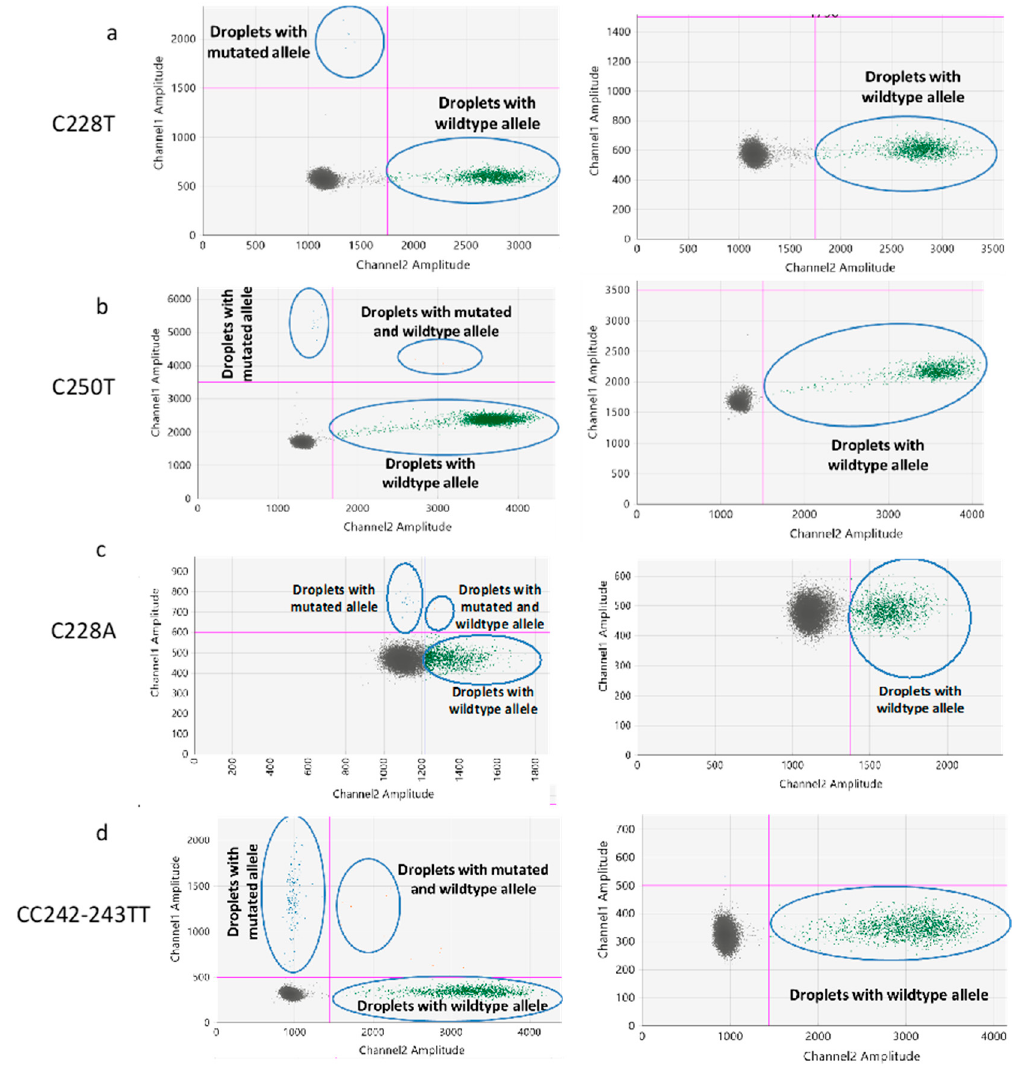
Figure 7. Examples of 2D scatterplots obtained from TERT promoter mutation ddPCR assays in representative samples. Assays testing for C228T ( a ), C250T ( b ), C228A ( c ), and CC242-243TT ( d ) mutations are displayed in four examples of mutated samples (left panels) and in four examples of wild-type samples (right panels). In the left panel, fluorescent probes (FAM) detect respective mutations as exemplified by the count of droplets with mutated alleles, while in the right panel, wild- type samples do not show any positive droplets (FAM) above the threshold line but show droplets with HEX fluorescence associated with wild-type probes. The pink lines are the thresholds for channel 1 (mutated probe) and channel 2 (wild-type probe) for the ddPCR mutation assays.